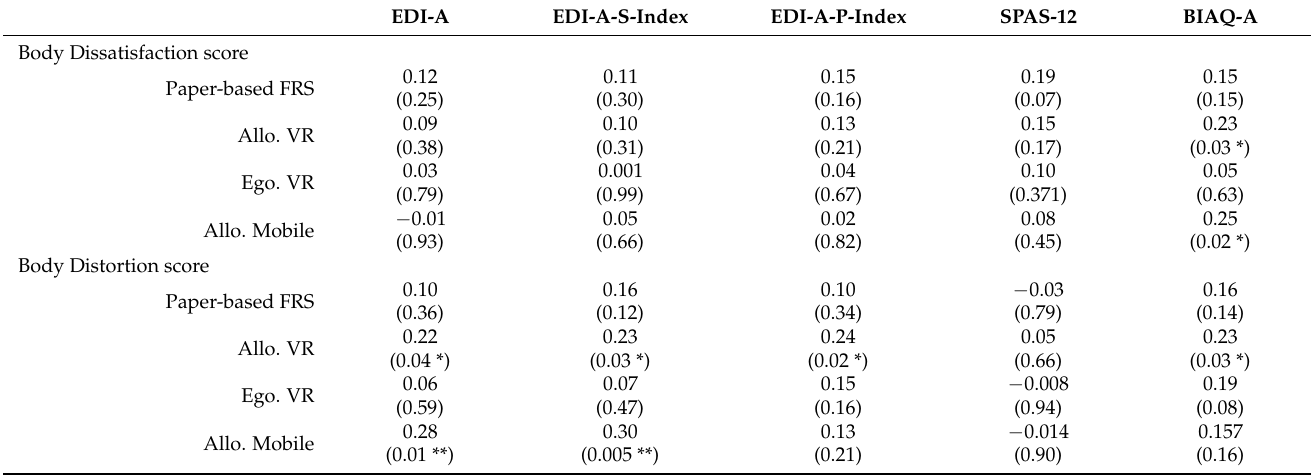
Table 3. Pearson correlations (with exact p values in brackets) for the total of questionnaires measuring components of BID and three rating scales administered to adolescents: a paper-based FRS, the e LoriCorps-IBRS 1.1 allocentric and egocentric perspectives, and the e LoriCorps-IBRS 1.1-Mobile allocentric perspective.